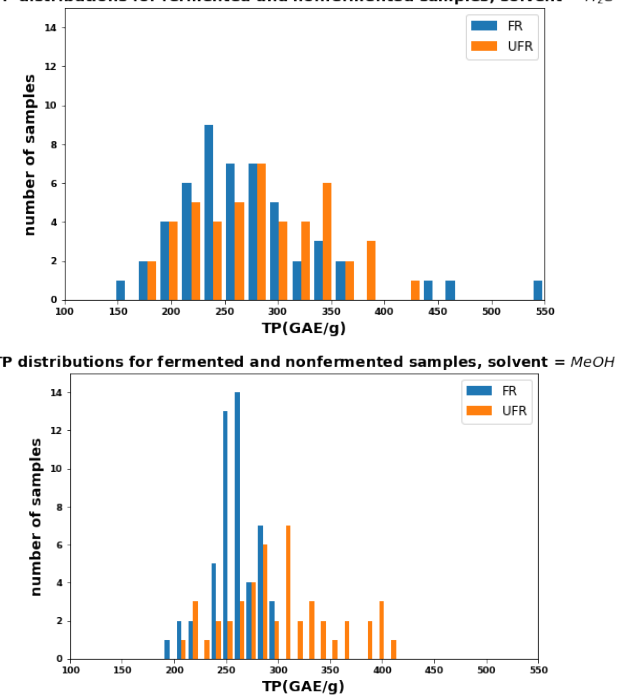
Figure 1. Distributions of total phenolics for FR and UFR using water ( top ) and methanol ( bottom ) as solvents.